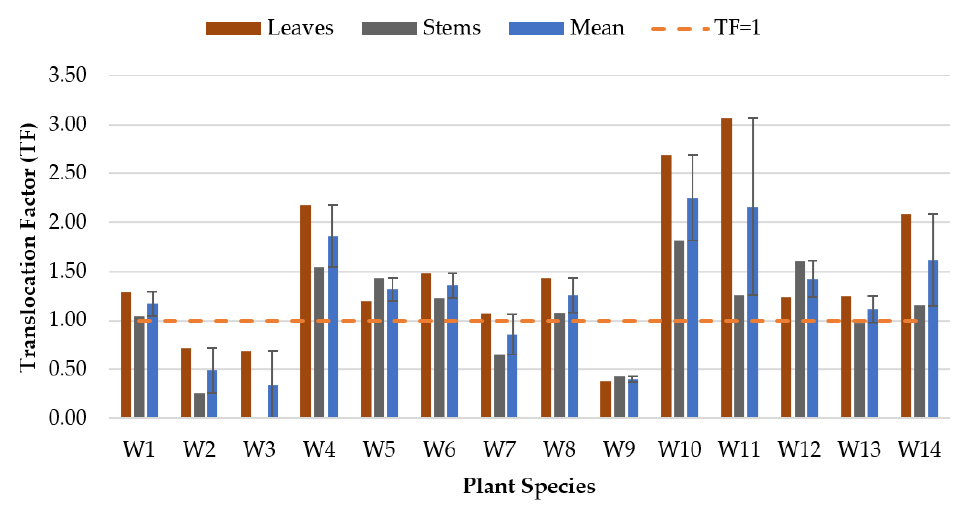
Figure 7. Translocation factor (TF) of calcium (Ca) in the phytoremediation of domestic sewage mesocosms using various tropical plants.